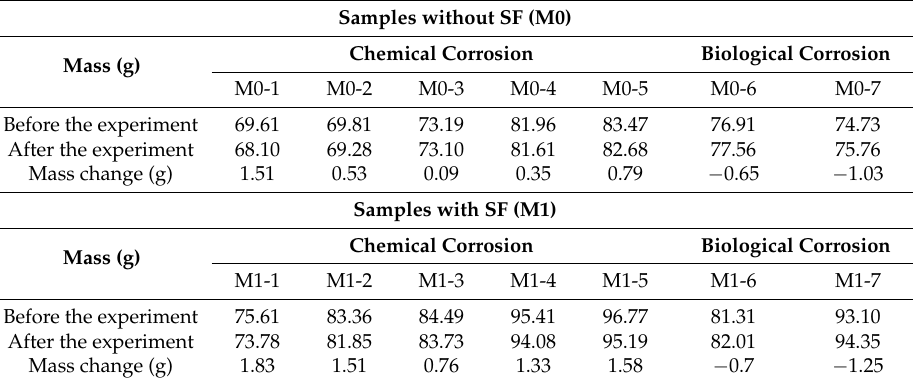
Table 4. Changes in mass after the 270-day